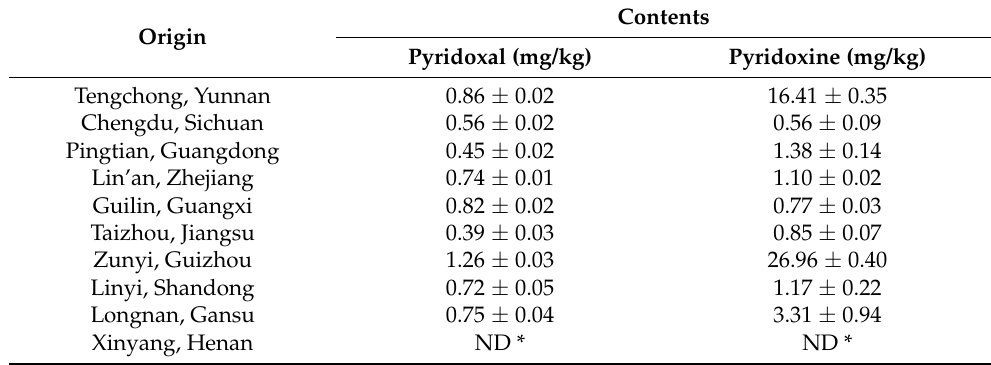
Table 3. Contents of pyridoxal and pyridoxine in ginkgo seeds from different regions (n = 3).